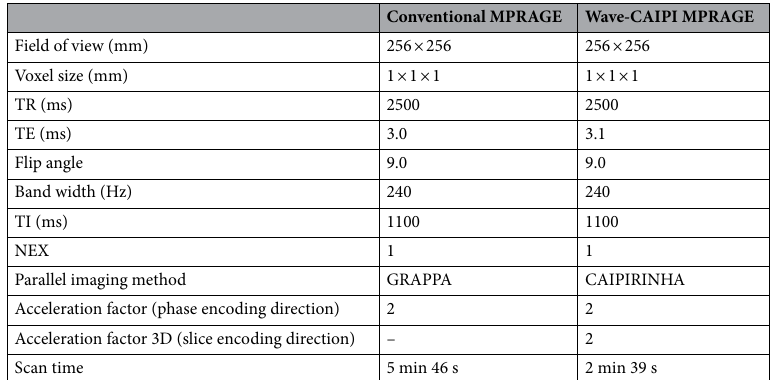
Table 1. Image parameters. CAIPIRINHA controlled aliasing in parallel imaging results in higher acceleration, GRAPPA generalized autocalibrating partially parallel acquisitions, MPRAGE magnetization-prepared rapid gradient echo, NEX number of excitations, TE echo time, TI inversion time, TR repetition time, wave-CAIPI wave-controlled aliasing in parallel